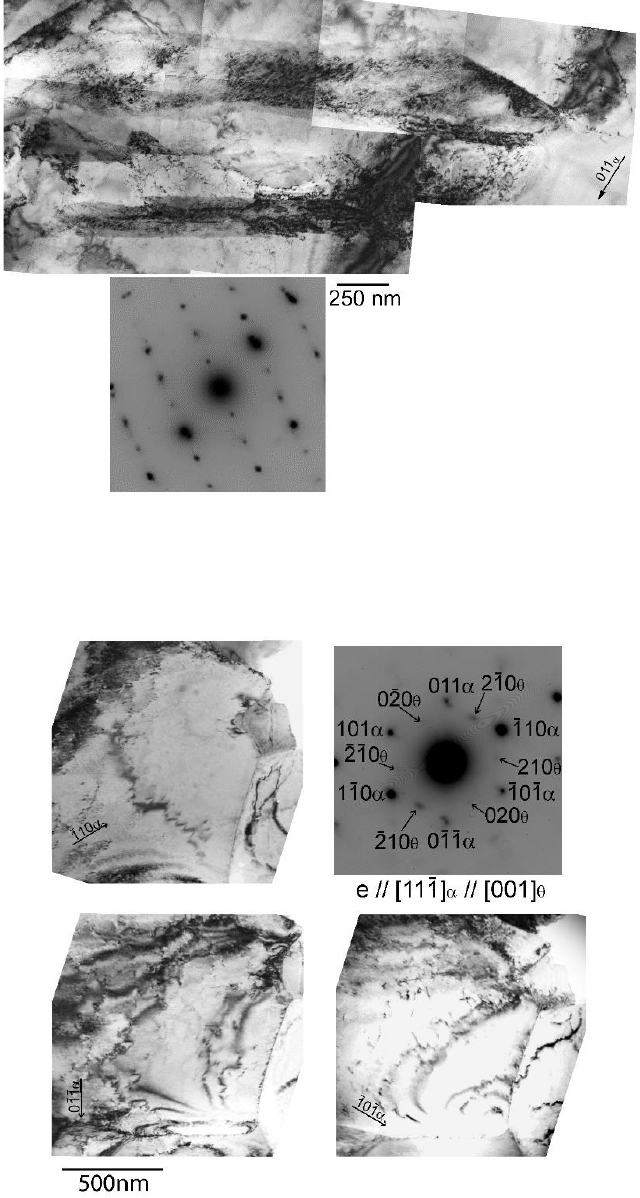
Figure 20. TEM micrograph of the TRIP5 steel for the 2% prestrained and aged at 170 ◦ C for 60 min, which reveals carbides in the structure of bainitic ferrite (up) and - the non-strained TRIP5 aged at 170 ◦ C for longer ageing time of 5000 min with θ -carbide precipitation